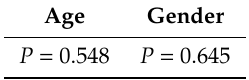
Table 8. Comparison of age, gender by success rate / number of attempts (between groups).